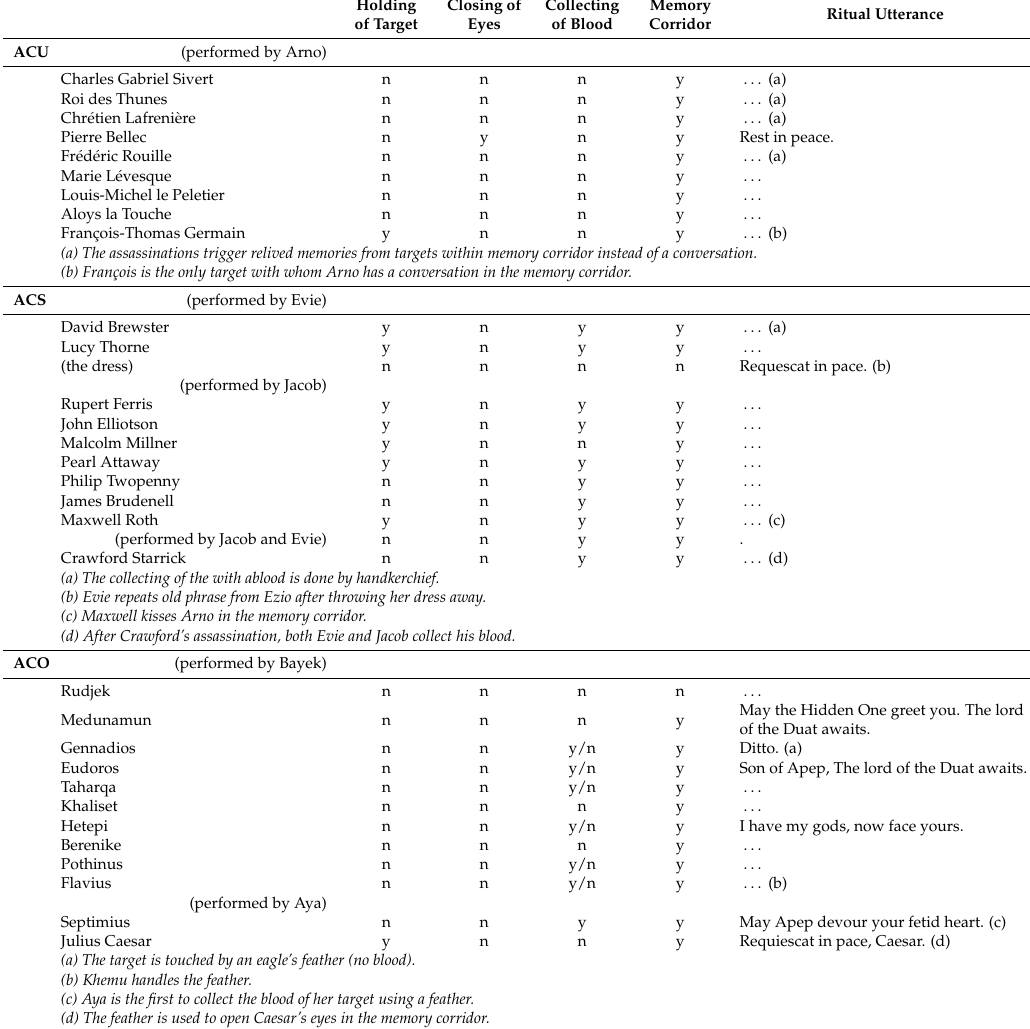
Table A1. Cont . Closing of Eyes